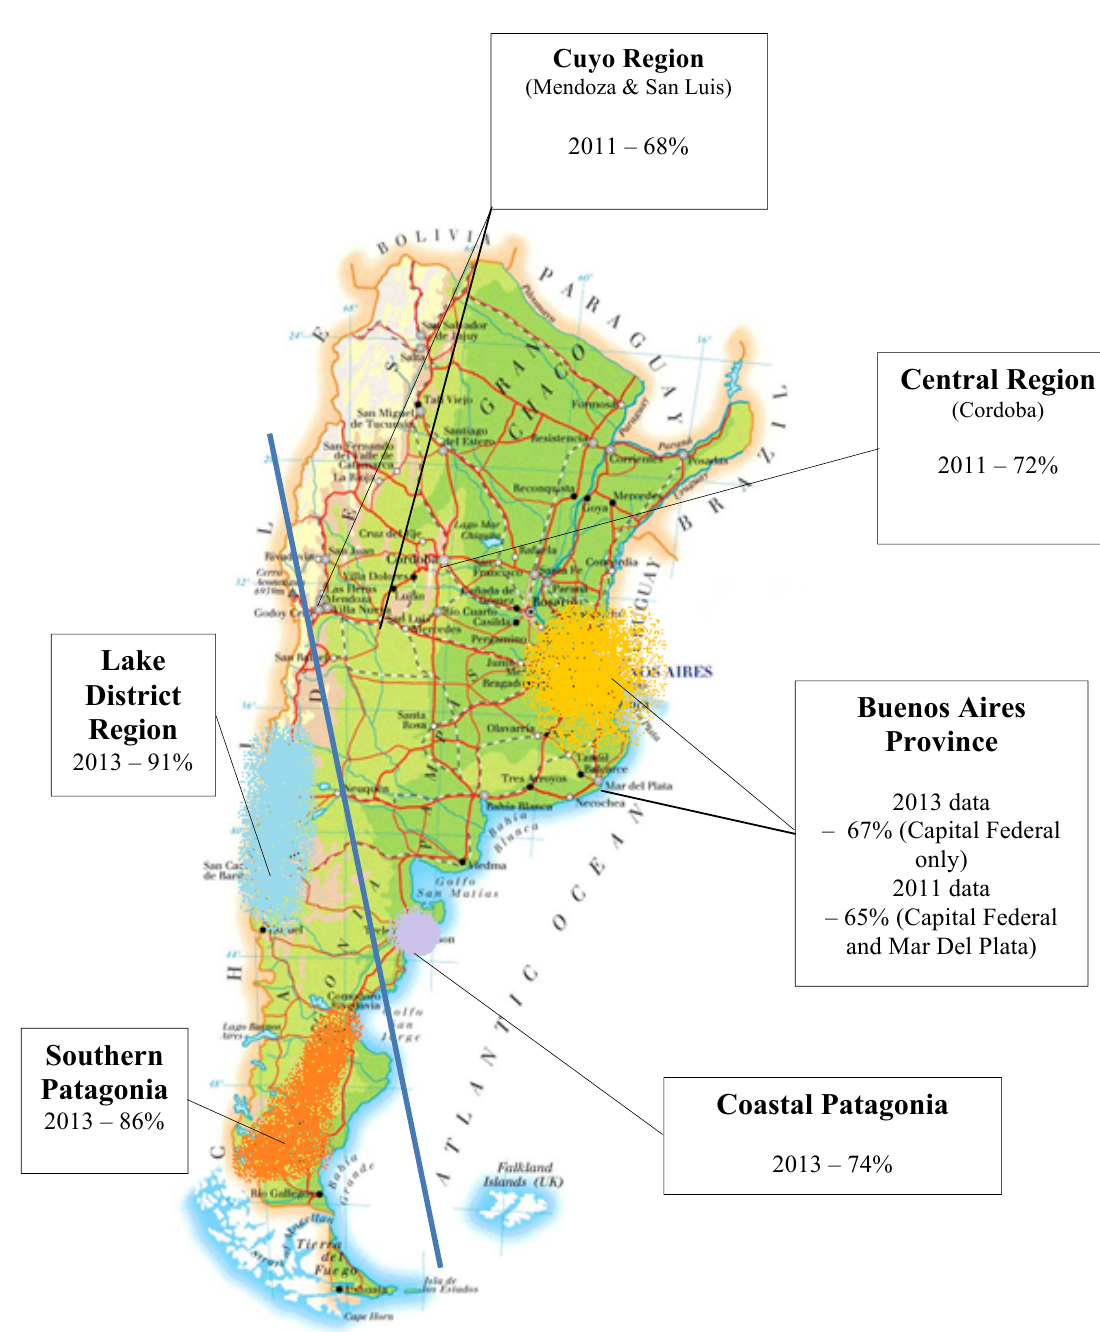
Figure 3. Map of CC acceptability rates from Whimpanny (2012) 2011 data and Ayres (2014) 2013 data, illustrating an isogloss across Argentina splitting higher-CC South Western and lower-CC North Eastern